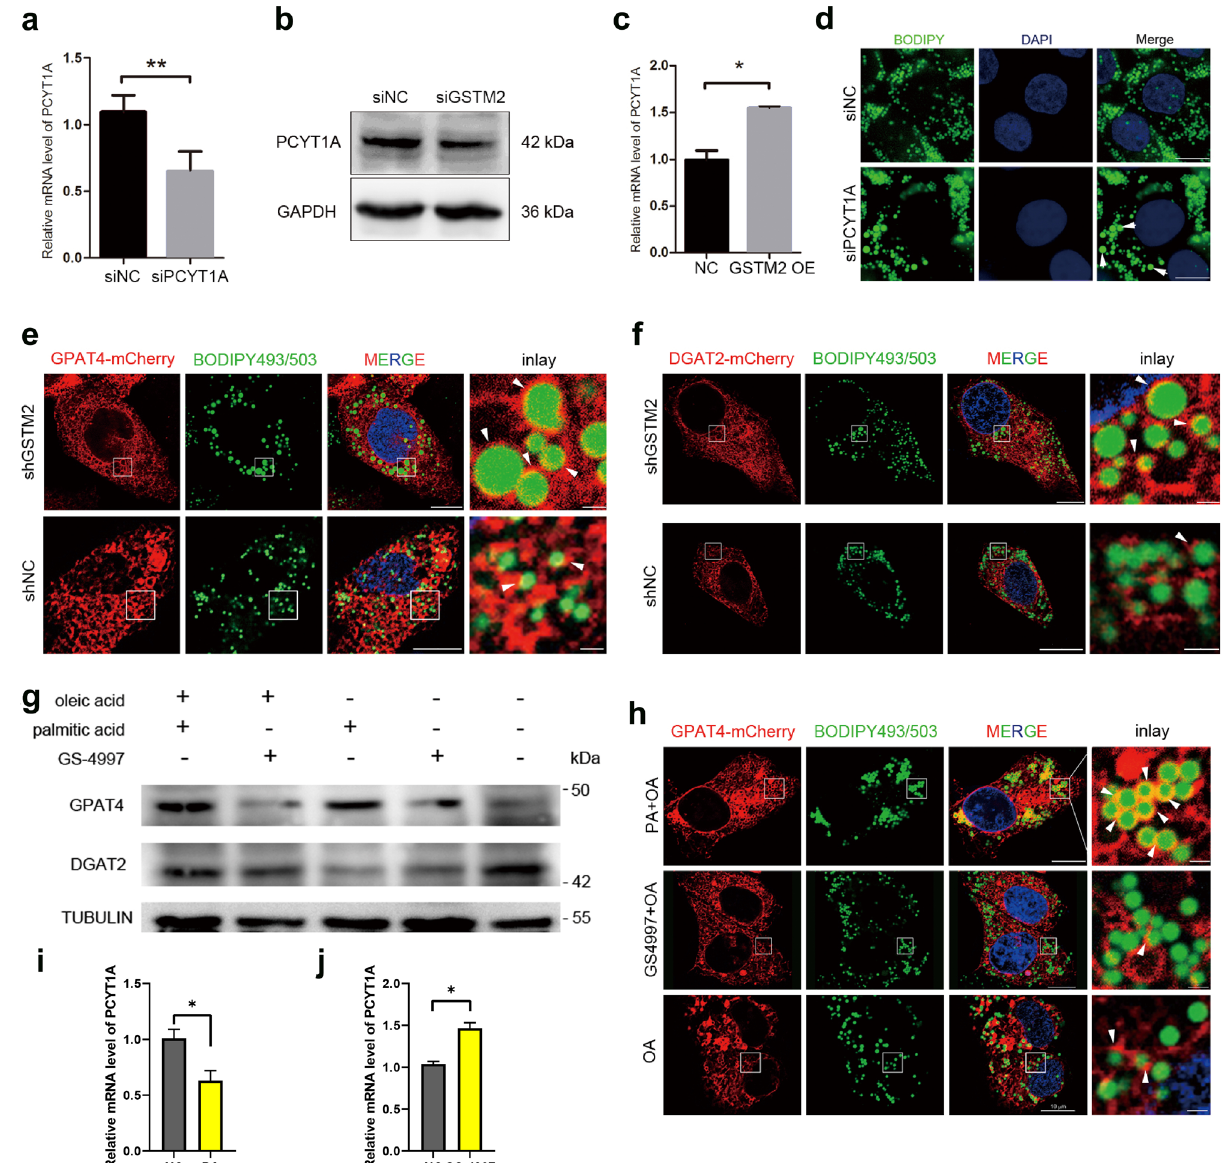
Fig. 5 GSTM2 modulated lipid droplet growth via ASK1 signalling. a – c PCYT1A expression level was down-regulated by GSTM2 KD and up-regulated by GSTM2 OE; * p < 0.05, ** p < 0.01. d PCYT1A KD induced LD expansion. e , f GSTM2 affected recruitment of GPAT4 and DGAT2 on LD surface (in